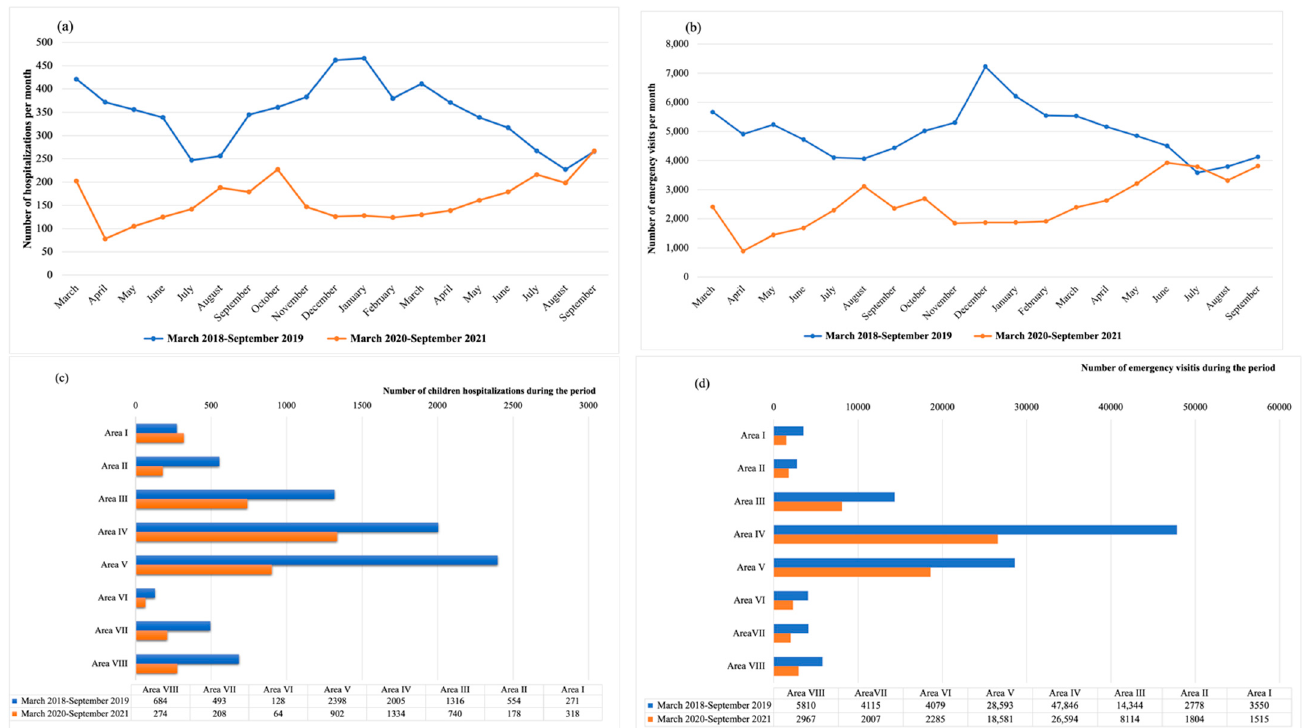
Figure 5. Comparison of pediatric healthcare utilization in Asturias between the periods 2018–2019 and 2020–2021. ( a ) Comparison of pediatric hospitalizations per month between periods; ( b ) com- parison of pediatric emergency visits per month between periods; ( c ) comparison of pediatric hos- pitalizations per health area between periods; ( d ) comparison of pediatric emergency visits per area between periods.